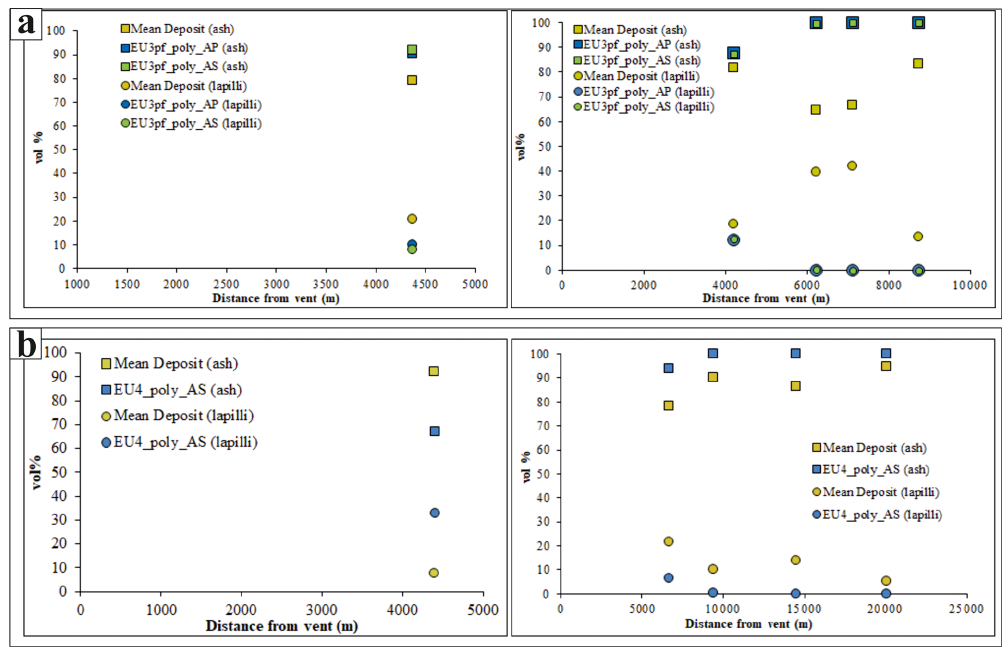
Figure 9. Volumetric content of ash or lapilli of model or deposit with distance to the source of the units (a) EU3pf N/S (left and right, respectively) and (b) EU4b/c NW/SE (left and right,